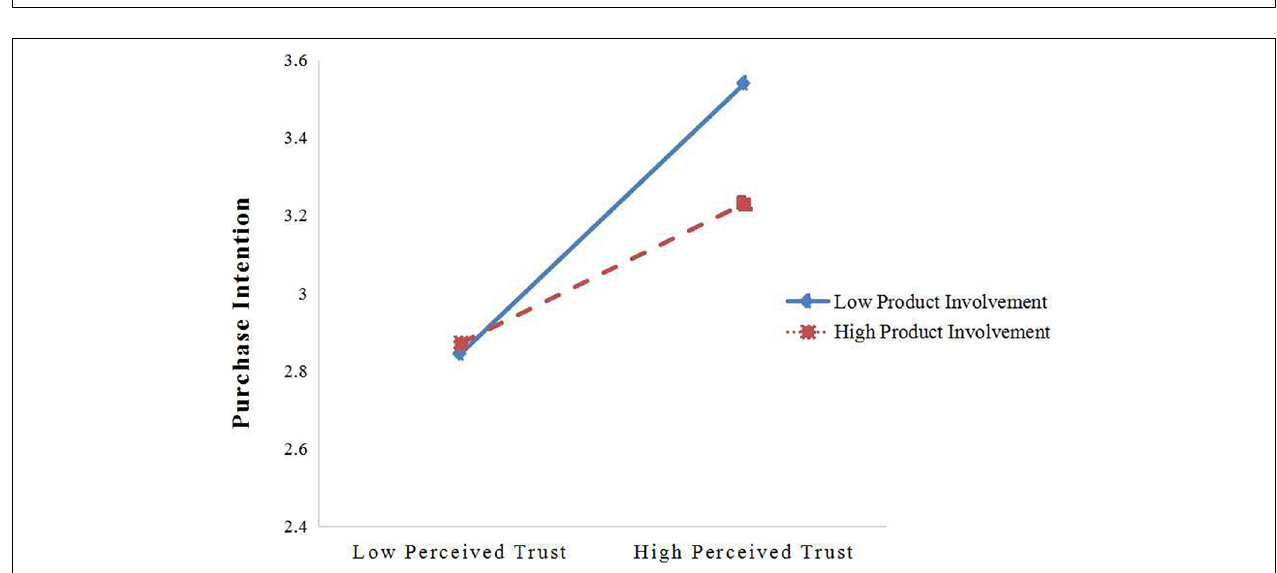
FIGURE 3 | Interaction of perceived usefulness and product involvement on purchase intention.